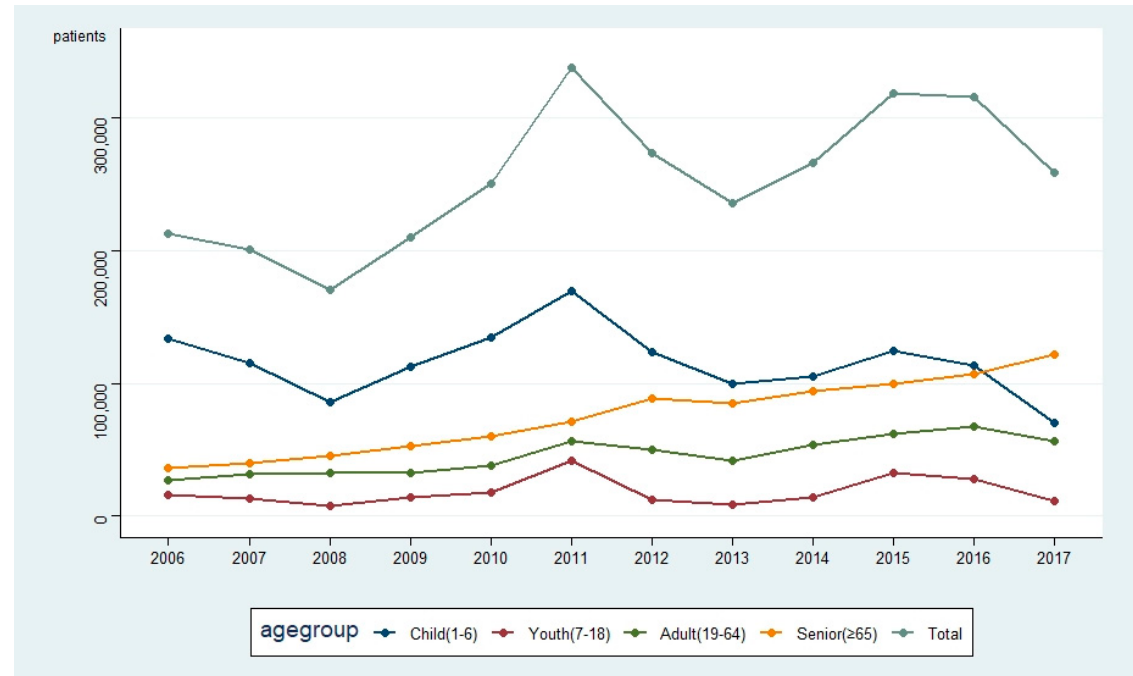
Figure 2. Weighted number of discharged pneumonia patients in each year and age group (2006–2017).